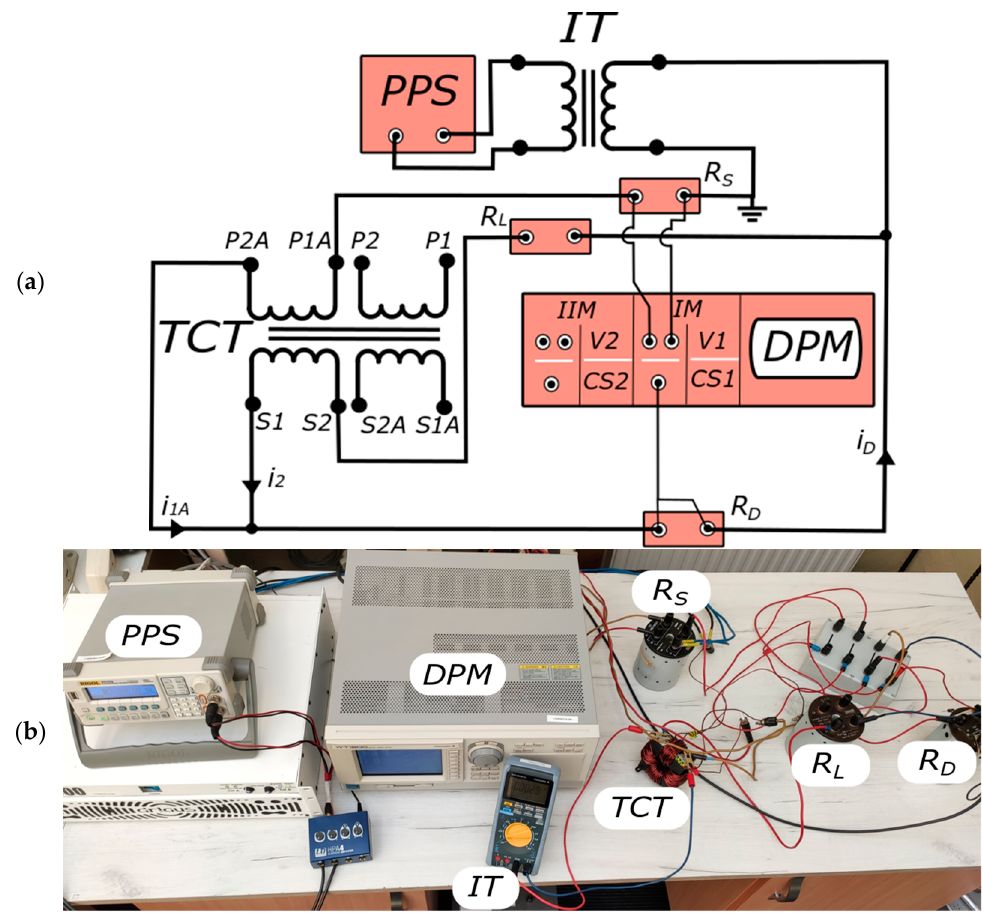
Figure 2. Measuring system for the evaluation of the current error and phase displacement of the inductive CT: ( a ) Electrical diagram; ( b ) Photo of the laboratory setup.